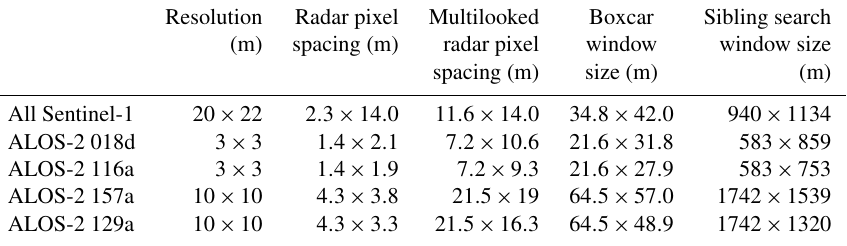
Table 1. The resolution and pixel spacing of the data at different stages throughout the processing for Sentinel-1, ALOS-2 on tracks A018d and A116a (Hokkaido), track A157a (Nepal), and track A129a (Lombok). Resolutions are given in range × azimuth coordinate